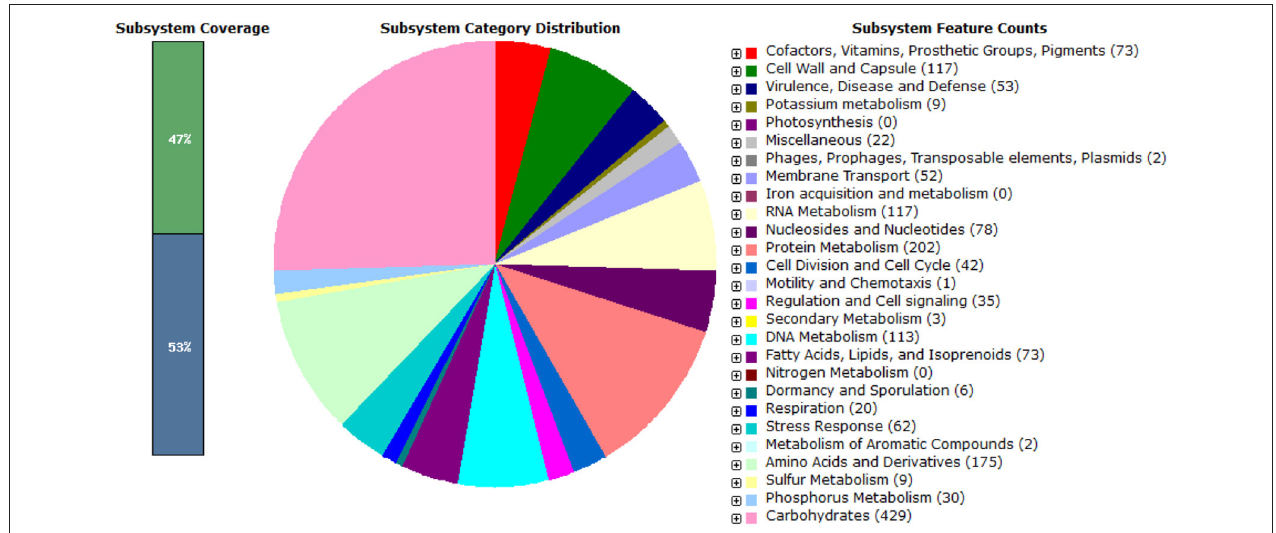
FIGURE 8 | Pie chart showing functional genome of Enterococcus mundtii QAUEM2808. The genes are predicted using FIGFams system integrated within RAST online server.